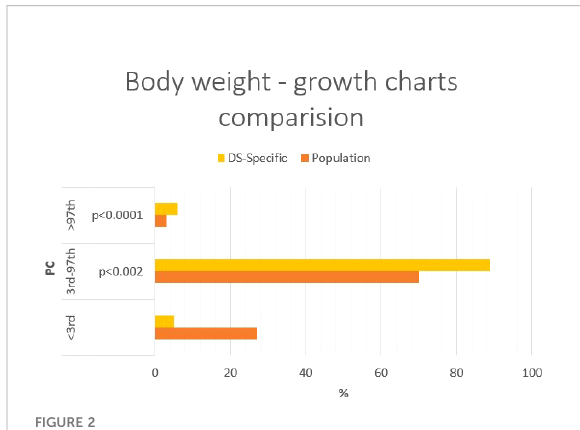
FIGURE 4 Percentage comparison of the number of individuals quali fi ed for the given BMI categories on the standard growth charts and DS- specialized growth charts.